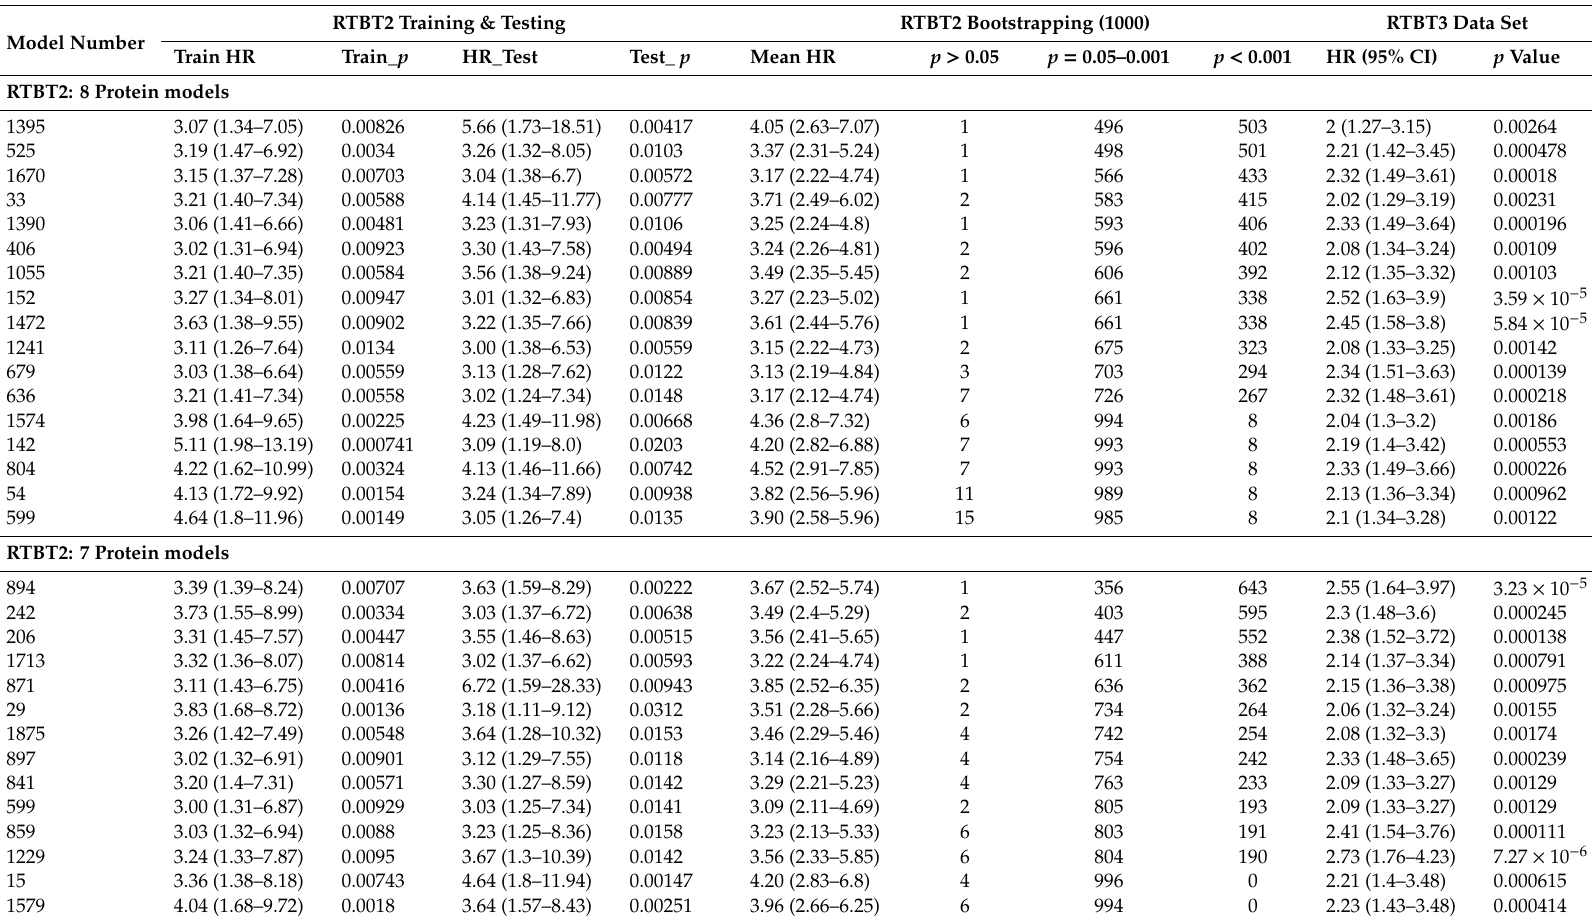
Table 3. Cox proportional hazards ratio (95% CI) for 10 indvidual proteins for three subgroups based on stage and treatment